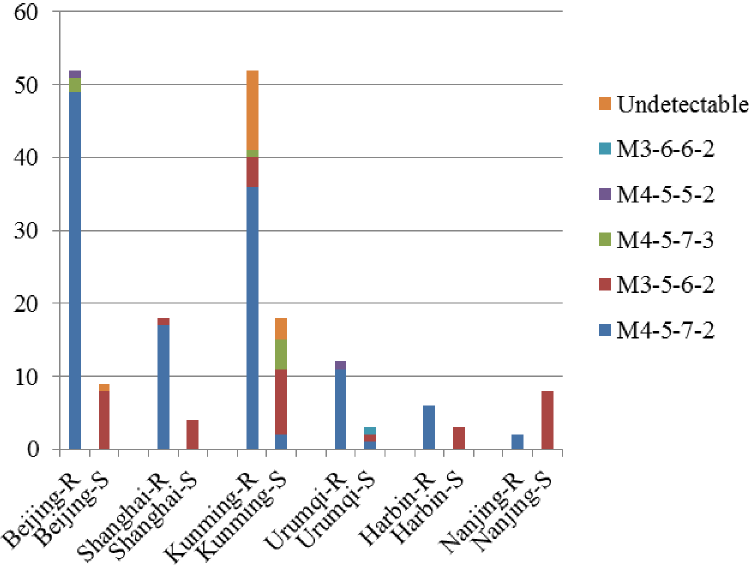
Fig 4. Different genotypes observed in macrolide-resistant and macrolide-sensitive specimens obtained from different sites in China. R, resistant; S, sensitive; Undetectable, the repeat number of the four loci could not be fully determined because of low DNA